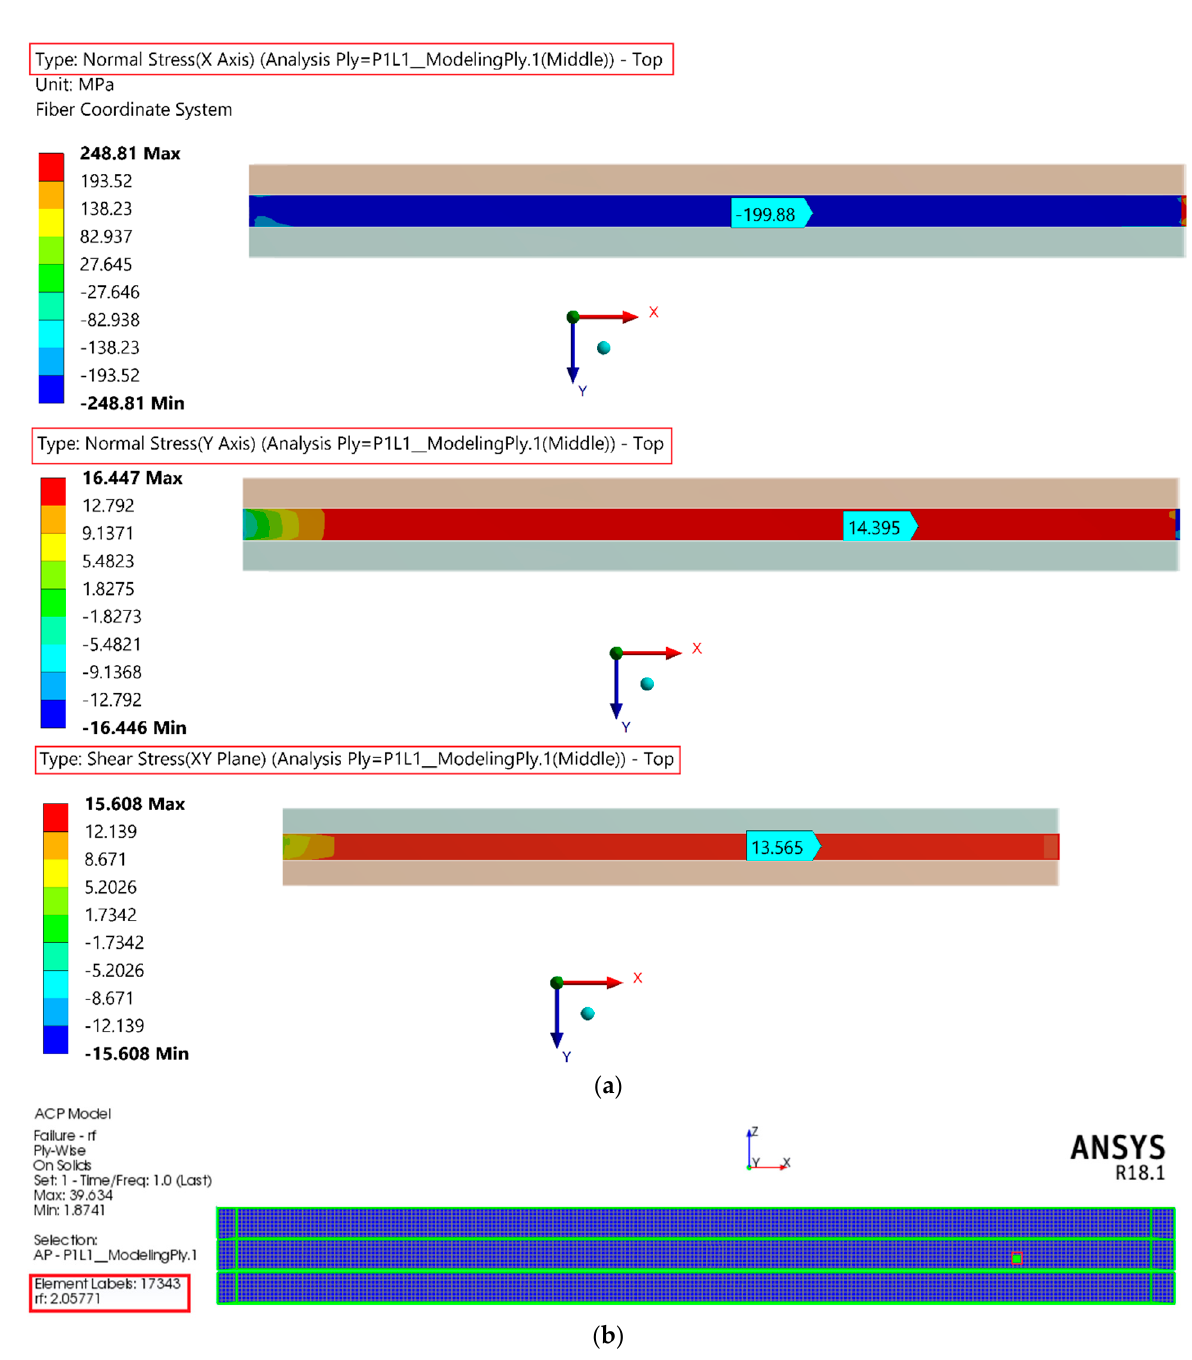
Figure A7. Stress components for a CFRP square beam with L2 layup: ( a ) normal stress components in the x ‐ and y ‐ directions and shear stress in the xy ‐ plane, and ( b ) safety ratio.